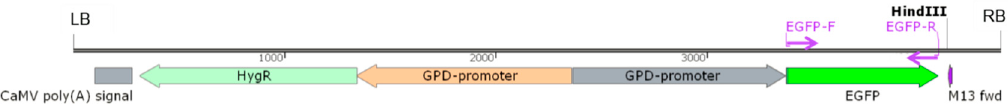
Figure 1. The T-DNA region of plasmid pCAMBIA-1300-GFP. hygR : the hygromycin B phosphotransferase gene as a selection marker; EGFP : the enhanced green fluorescent protein as a reporter gene; GPD-promoter: the glyceraldehyde-3-phosphate dehydrogenase promoter of L. edodes ; LB: left border; RB: right border. Table 1. The primers used in this study.